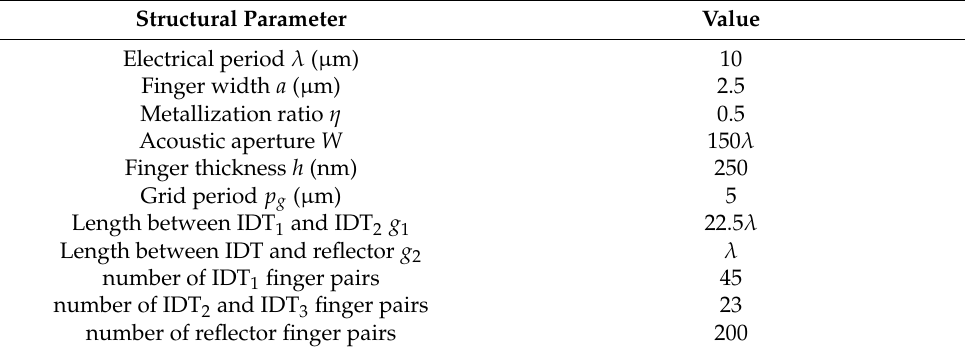
Table 2. Structure parameters of SAWR.